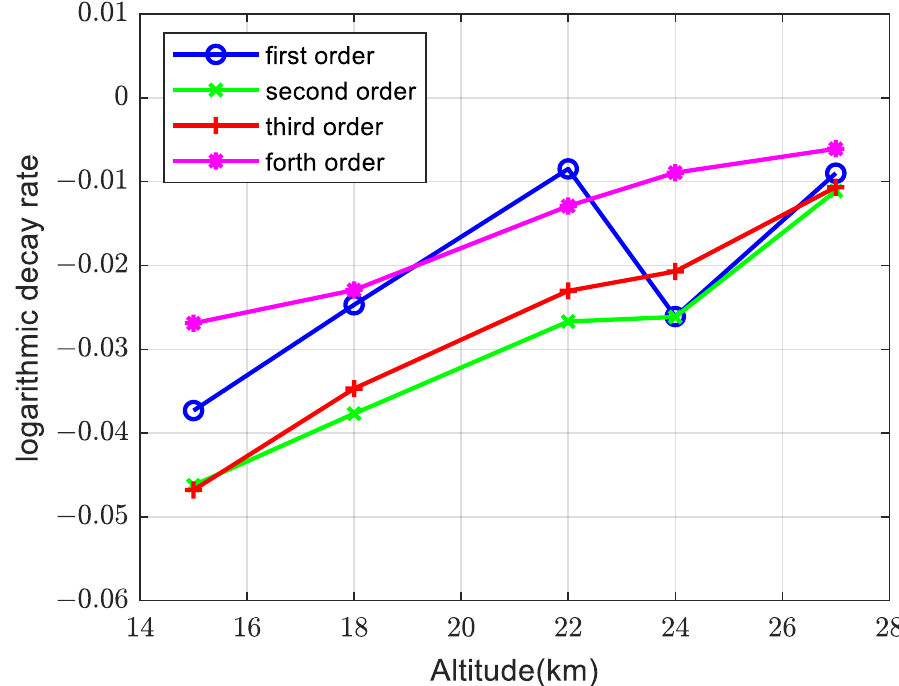
Figure 26. Variations in the logarithmic decay rate of the generalized displacement with path one.